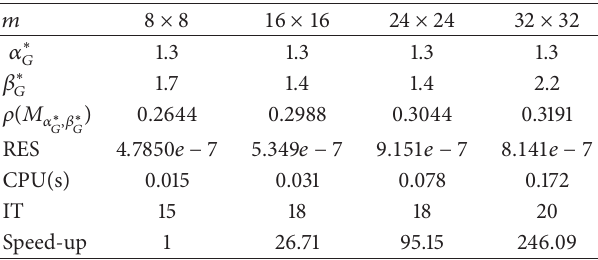
Table 5: Numerical results for GPMHSS with 𝑃 1 = 𝑇 and 𝑃 2 = 𝑊